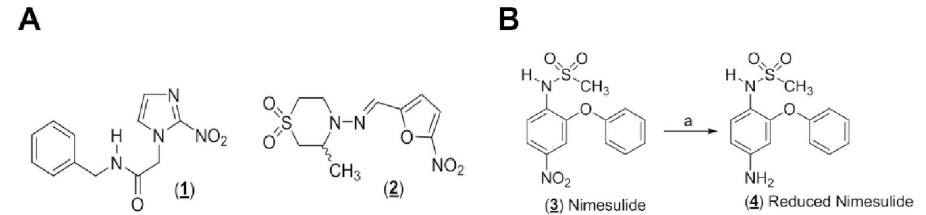
Fig 1. A . Chemical structures of benznidazole (BZN, 1 ) and nifurtimox (NFX, 2 ), the only drugs available to the treatment of Chagas disease. B . Synthesis of the aniline 4 through chemoselective reduction of nimesulide 3 . Reaction conditions: (a) Fe 0 , NH 4 Cl, ethanol/water, reflux (64%).